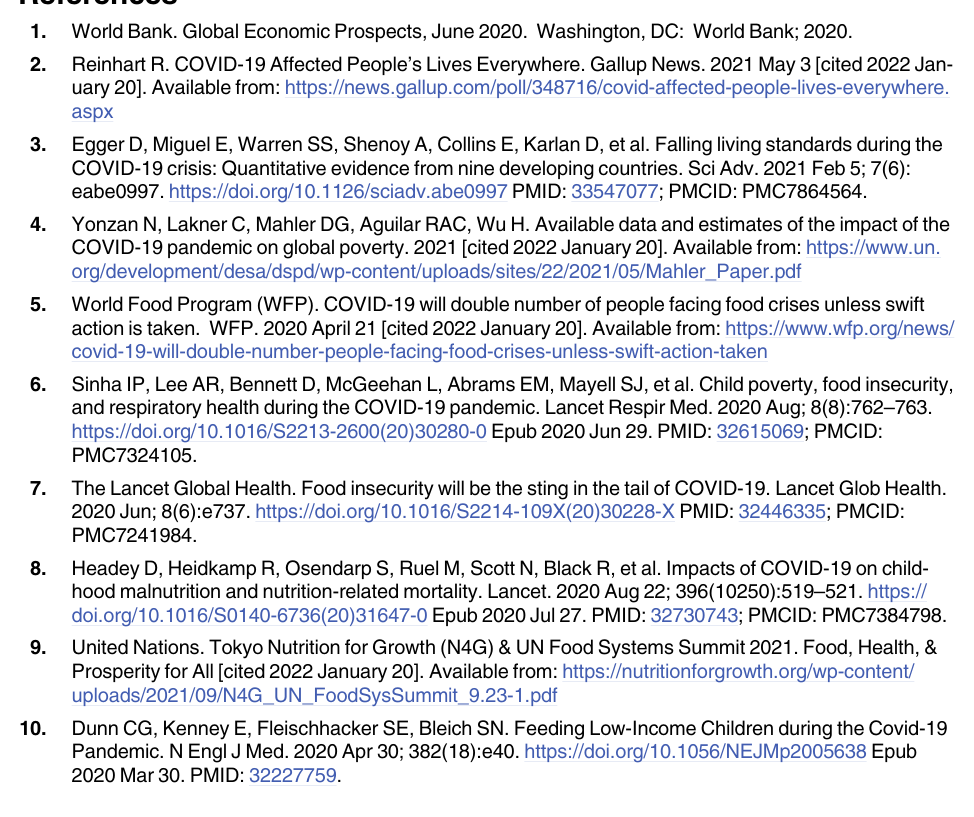
S2 Fig. Total migration events during Jan 2020-March 2021, by slum area. (TIF) S3 Fig. Place where medical advice was sought when child was last sick with cough or fever. (TIF) S4 Fig. Kernel density estimates of HAZ and WHZ distributions (full sample and by sub-